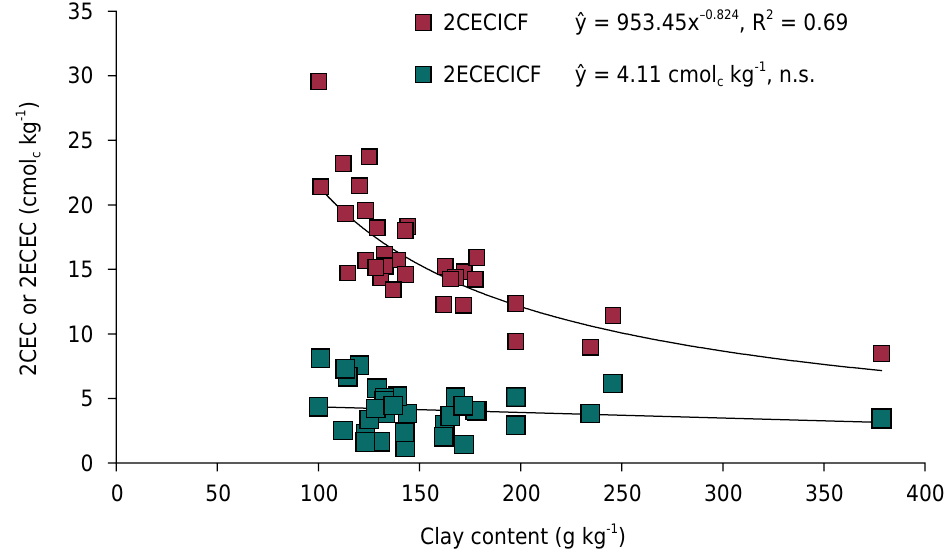
Figure 4. Cation exchange capacity (2CEC ICF ) and effective cation exchange capacity (2ECEC ICF ) of the inorganic clay fraction regarding the percentage of clay size fraction content for the soil samples. ns: non significative